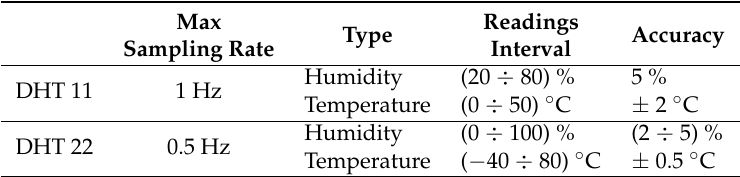
Table 3. DHT 11–DHT 22 details.